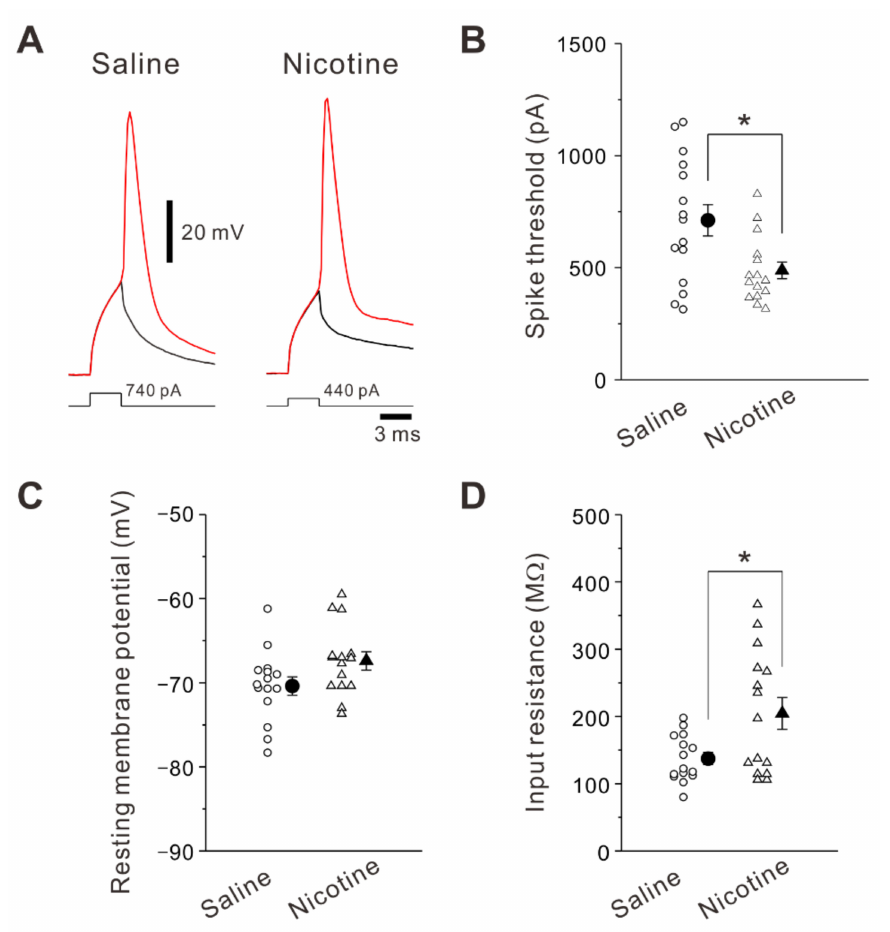
Figure 4. Effects of adolescent nicotine exposure on intrinsic membrane properties. ( A ) Sample traces of voltage responses to depolarizing current pulses at spike current threshold that induce spikes at 50% probability in PNs of a saline-treated mouse (left) and a nicotine-treated mouse (right). ( B – D ) Summary data of spike current threshold ( B ), resting membrane potential ( C ), and input resistance ( D ) obtained from PNs of saline-treated mice (n = 15 neurons/6 mice) and nicotine-treated mice (n = 15 neurons/7 mice). Unpaired t -test, *: p <